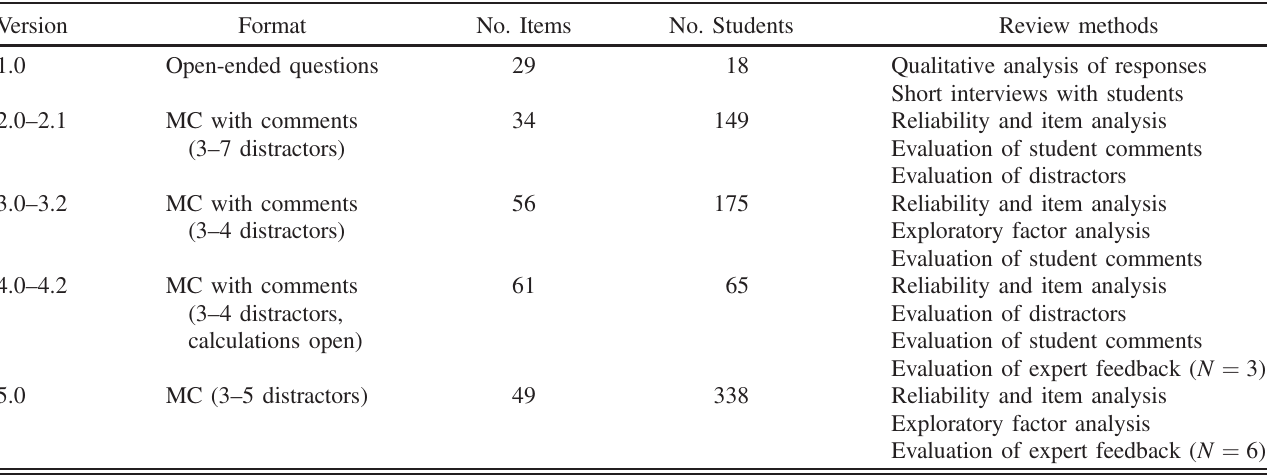
TABLE II. Development stages of the kinematics concept test. The format MC stands for multiple-choice items. The review methods at each stage are mentioned in the right column. Item analysis includes the calculation of difficulties, item-total correlations, and discrimination